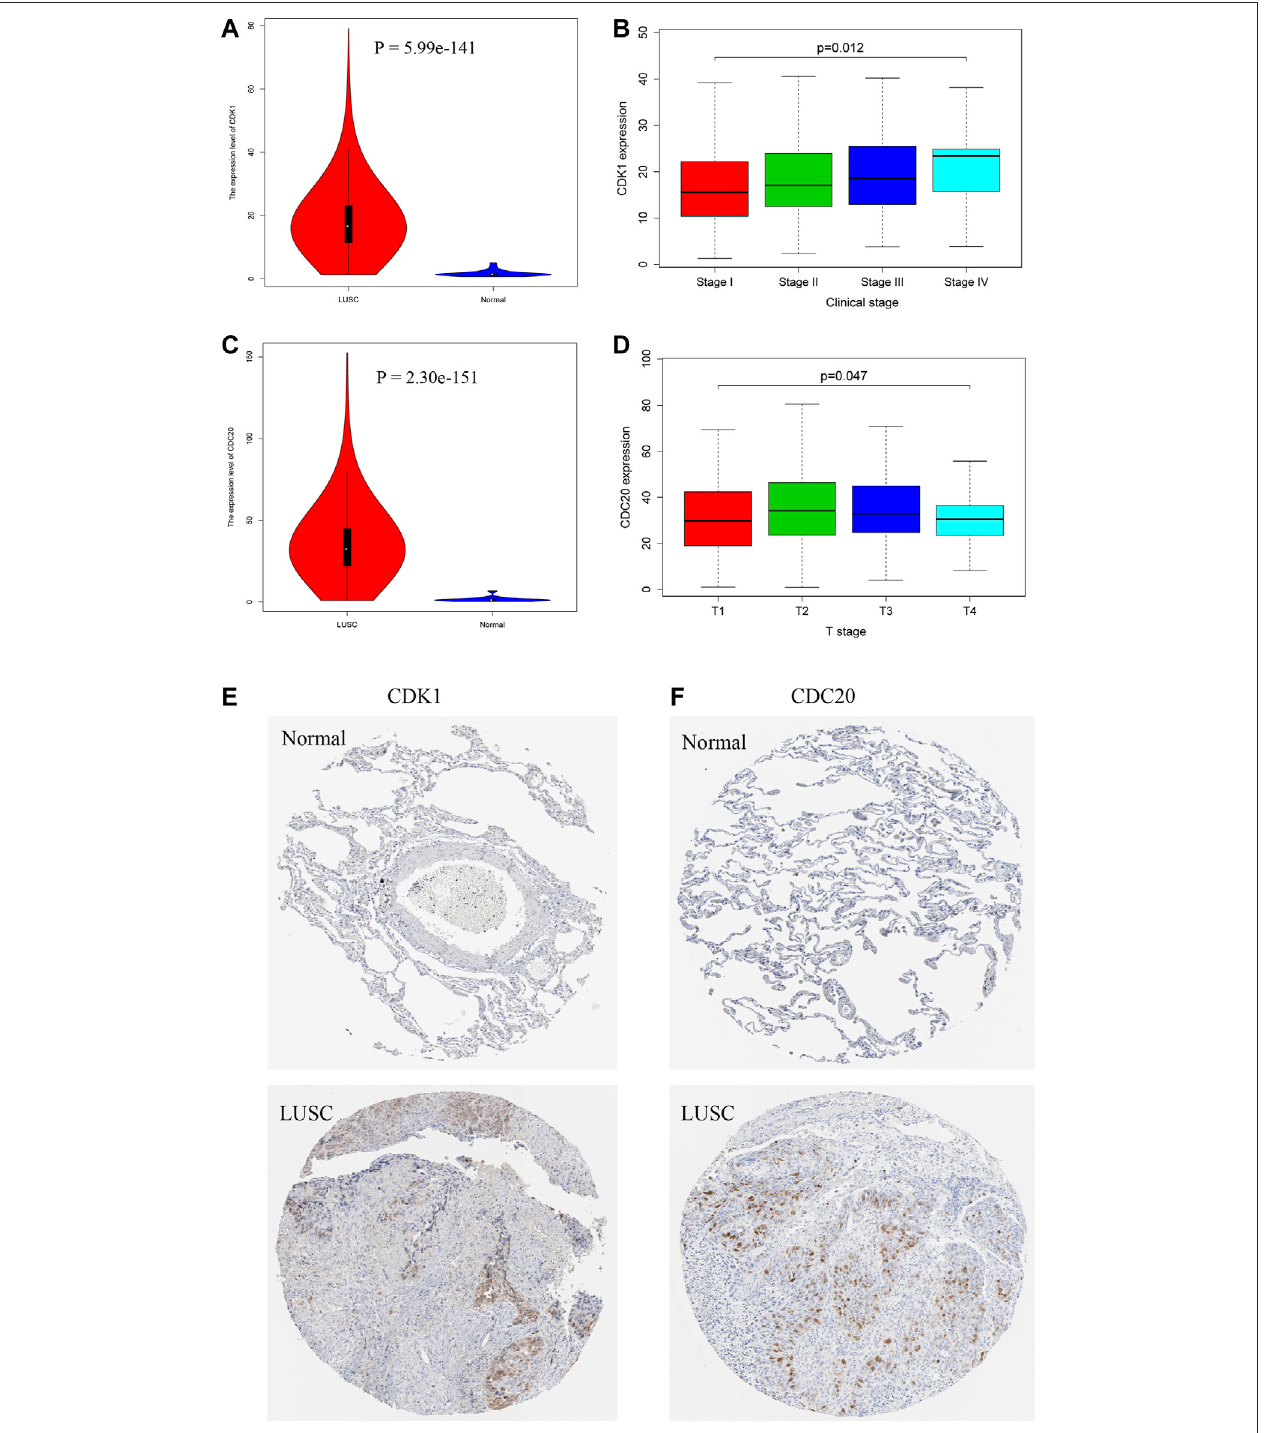
FIGURE 7 | The expression levels of hub genes in LUSC based on TCGA and THPA databases. CDK1 (A) and CDC20 (C) are obviously upregulated in LUSC tissues. CDK1 is signi fi cantly associated with clinical stages (B) , and CDC20 is signi fi cantly correlated with T stages (D) . Immunohistochemistry (IHC) results reveal that CDK1 (E) and CDC20 (F) are overexpressed in LUSC tissues compared with normal tissues.